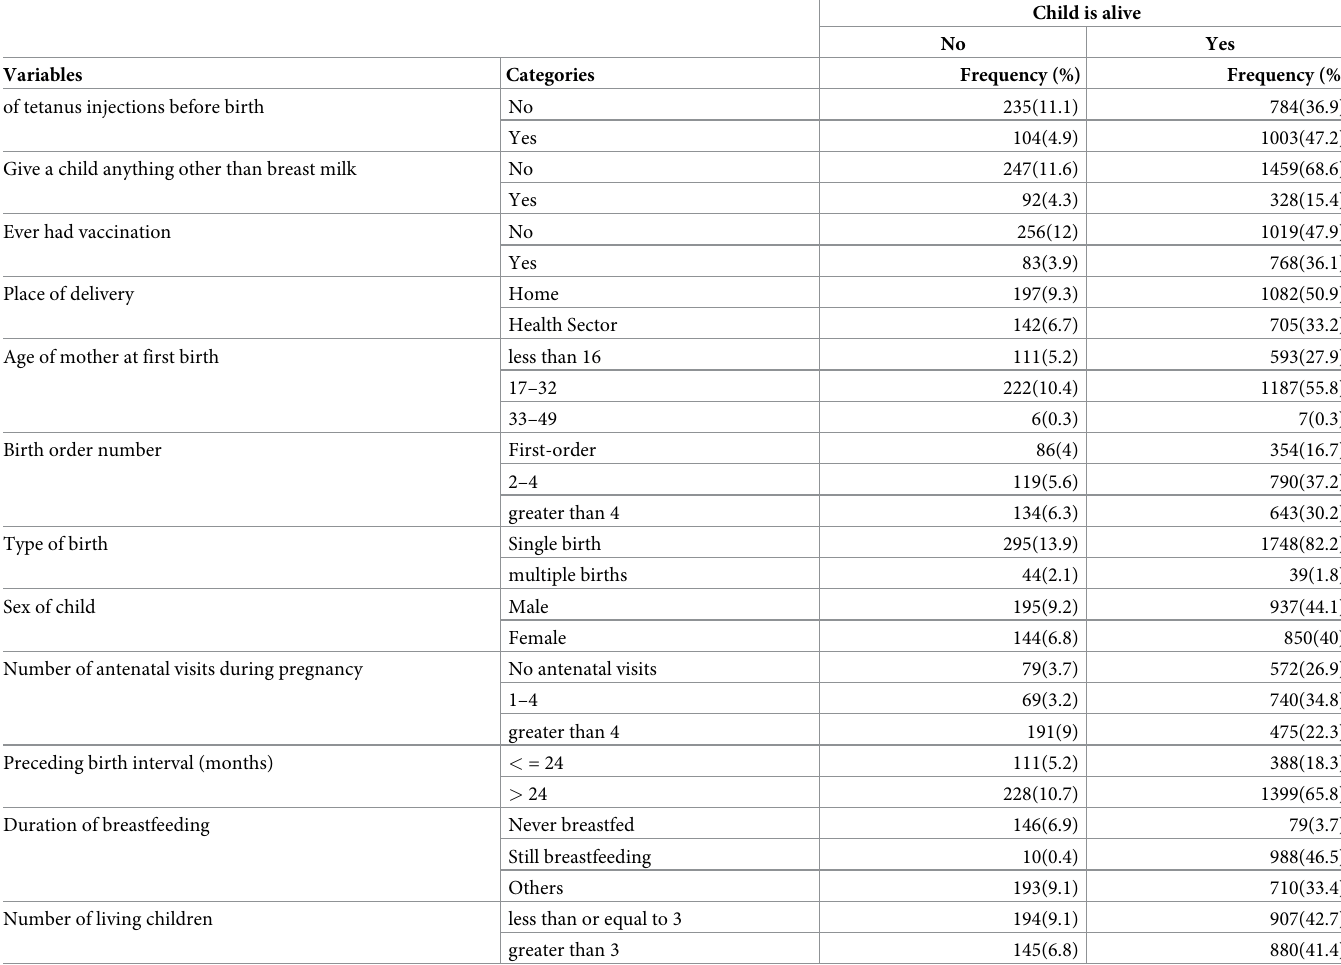
Table 3. Obstetric characteristics of post neonatal mortality